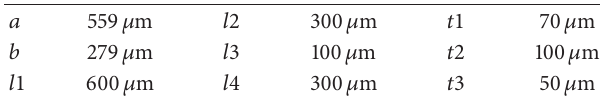
Table 1: Optimized dimensions of the 10 dB directional coupler.